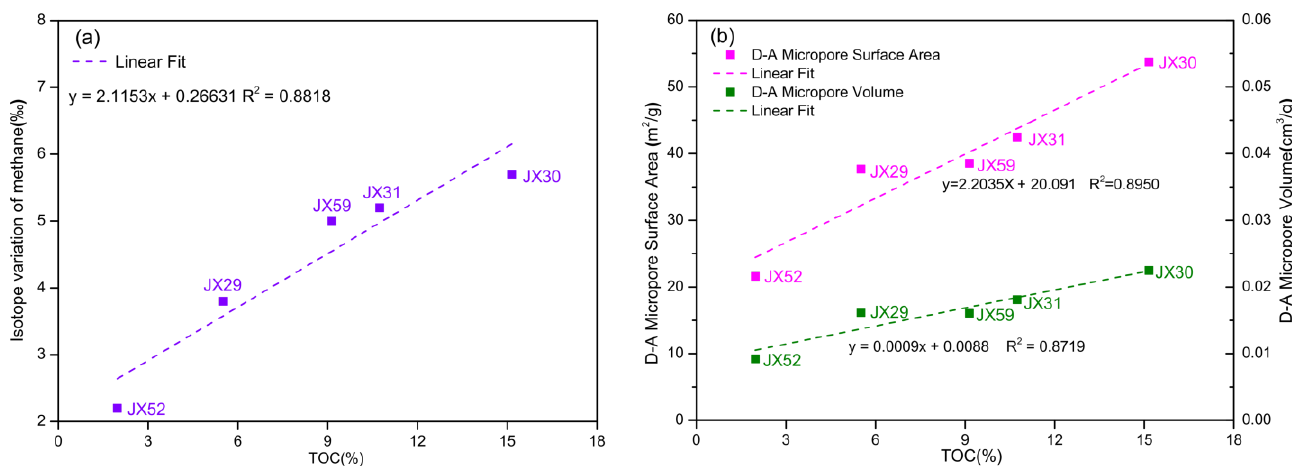
Figure 9. Variation in the values of δ 13 C CH4 with D-A micropore surface area and micropore vol- ume during shale gas degassing.